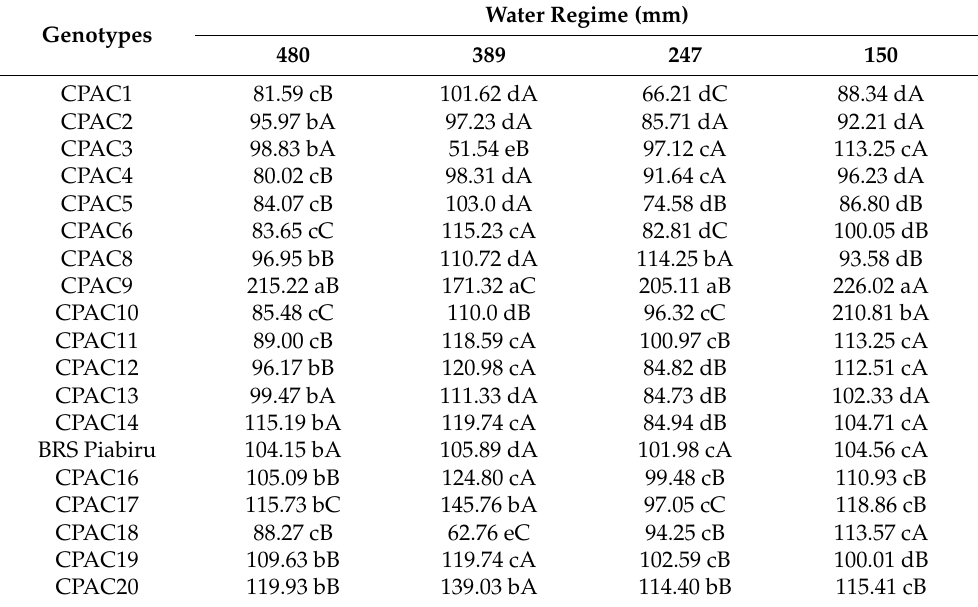
Table 3. Total flavonoid concentrations (mg/100 g) in grains of 18 quinoa genotypes and BRS Piabiru under 4 water regimes.